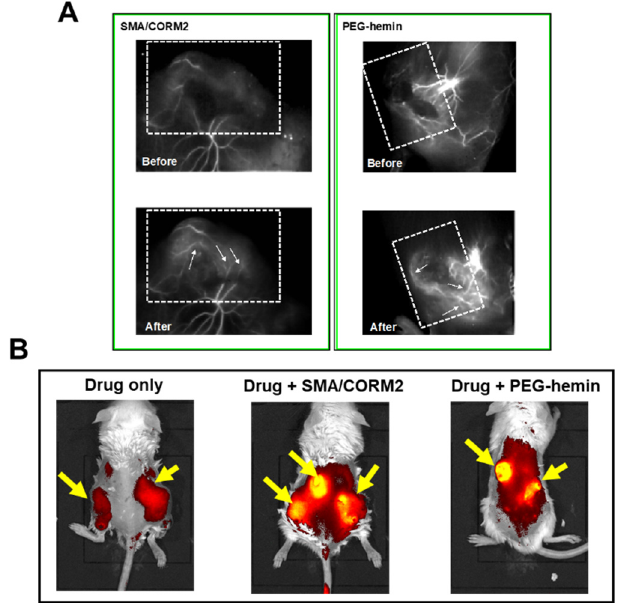
Figure 5. Enhancement of the EPR effect via nano-sized carbon monoxide (CO) donors [SMA/CORM2 and polyethylene glycol (PEG)-hemin] in S180 and C26 tumors. Fluorescence angiography demonstrated improved tumor blood flow after use of SMA/CORM2 and PEG-hemin in S180 tumor-bearing mice ( A ). Increased tumor delivery of P-PyF given at 5 mg/kg iv in the C26 tumor model with CO donors was confirmed by means of in vivo fluorescence imaging (IVIS) at 24 h after drug injection ( B ). Arrows indicate the tumor. Please see Fang et al. [10,30].